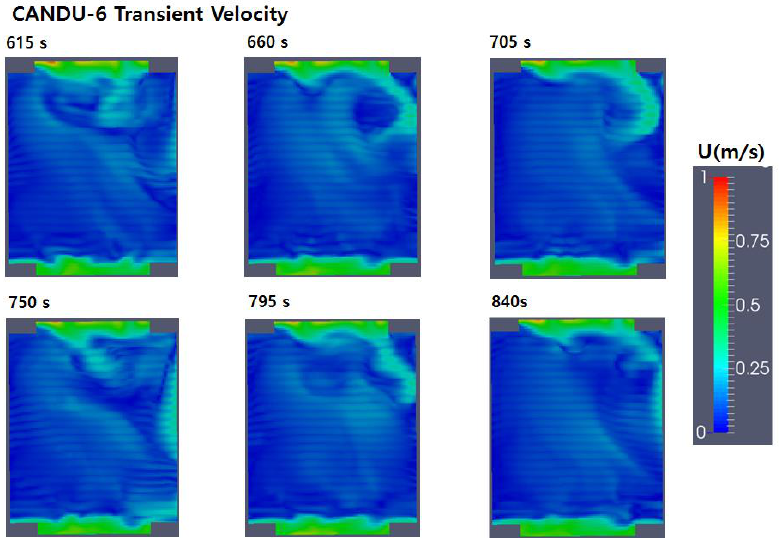
Figure 9. Velocity distribution at x = 0; 615 – 840 s.